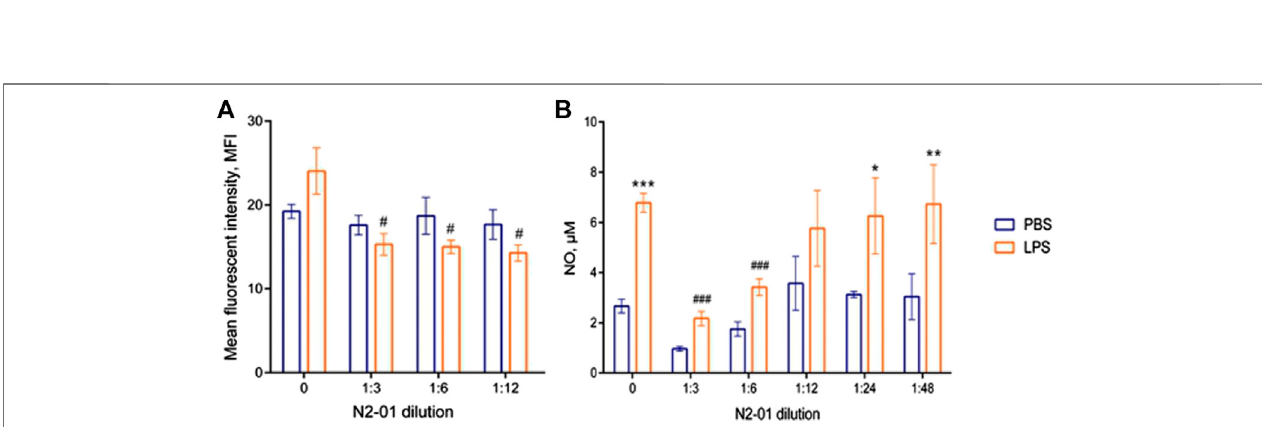
FIGURE 5 | The effect of N2-01 on iNOS (A) expression level and NO (B) production by mouse peritoneal lavage cells. Statistical assessment of differences was performed using ANOVA, and pairwise comparison of the mean values was performed using the Tukey HSD test. Data are expressed as mean ± SEM of at least three individualexperiments( n (cid:2) 3).Thedifferencesaresigni fi cant:a)ANOVA p < 0.05;#- p < 0.05vsLPS;b)ANOVA p < 0.001;*- p < 0.05,***- p < 0.001vscontrol;##- p < 0.01 vs LPS.